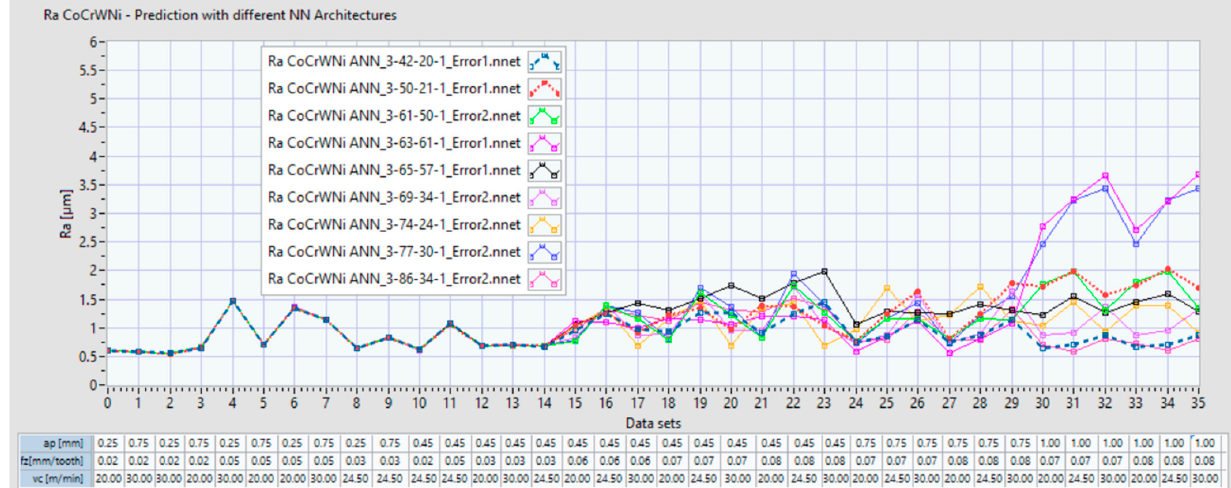
Figure 18. Prediction of Ra with 10 ANNs for Co-20Cr-15W-10Ni with a data set of 36